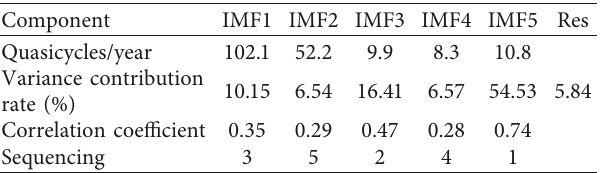
Figure 6: Normalized marginal spectrum of the sunspot number. Table 2: Variance contribution rate, correlation coefficient cal- culation, and sorting condition of IMF components of the sunspot